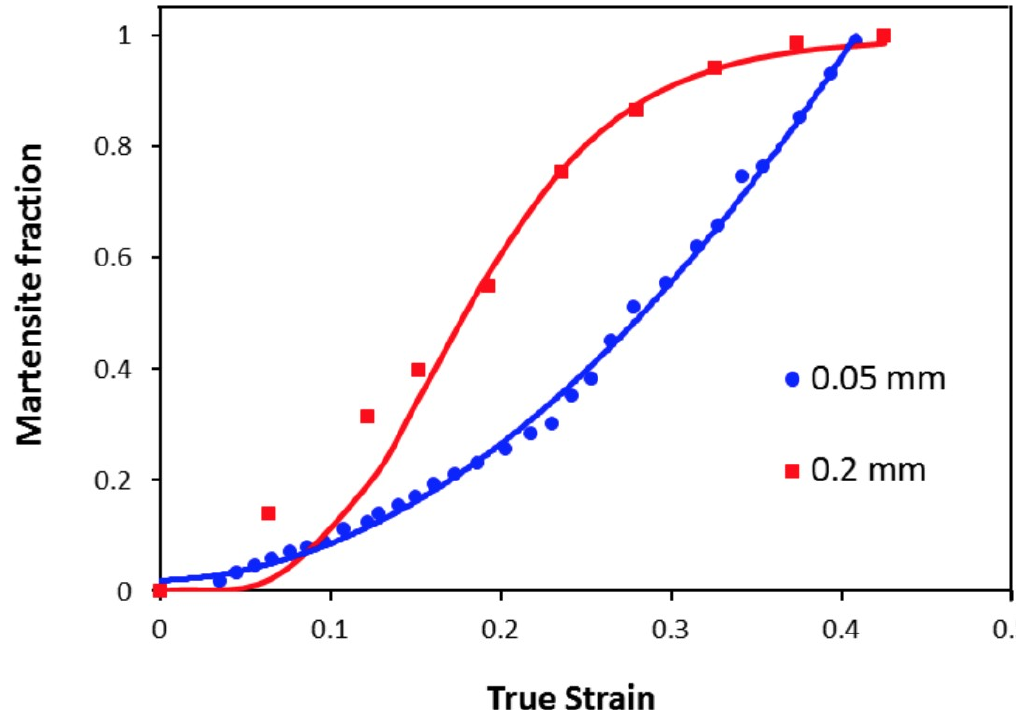
Figure 6. The influence of pass reduction on the variation of SIM during the cold rolling of Ti-bearing 201L steel.